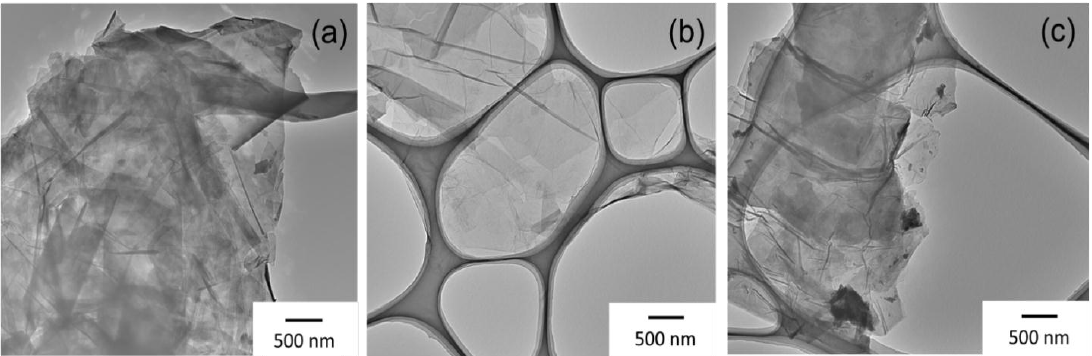
Figure 2. TEM images of ( a ) GNP; ( b ) GO; and ( c ) rGO samples.